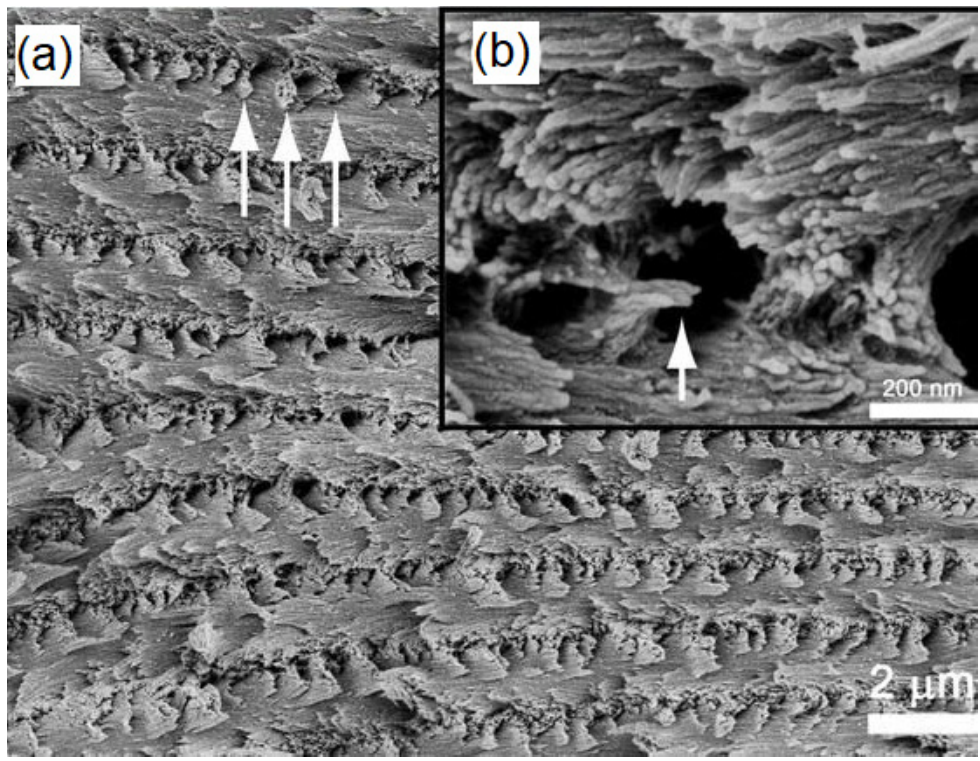
Figure 7. SEM images of the fractured surface across the cellulose nanocrystal (CNC) film ( a ) High magnification image of the layered structure of the film, ( b ) Cross-sectional image showing (inset Figure b) the helicoidal arrangement of nanocrystals. [70]. (Reprinted with permission from Majoinen et al., 2012.)